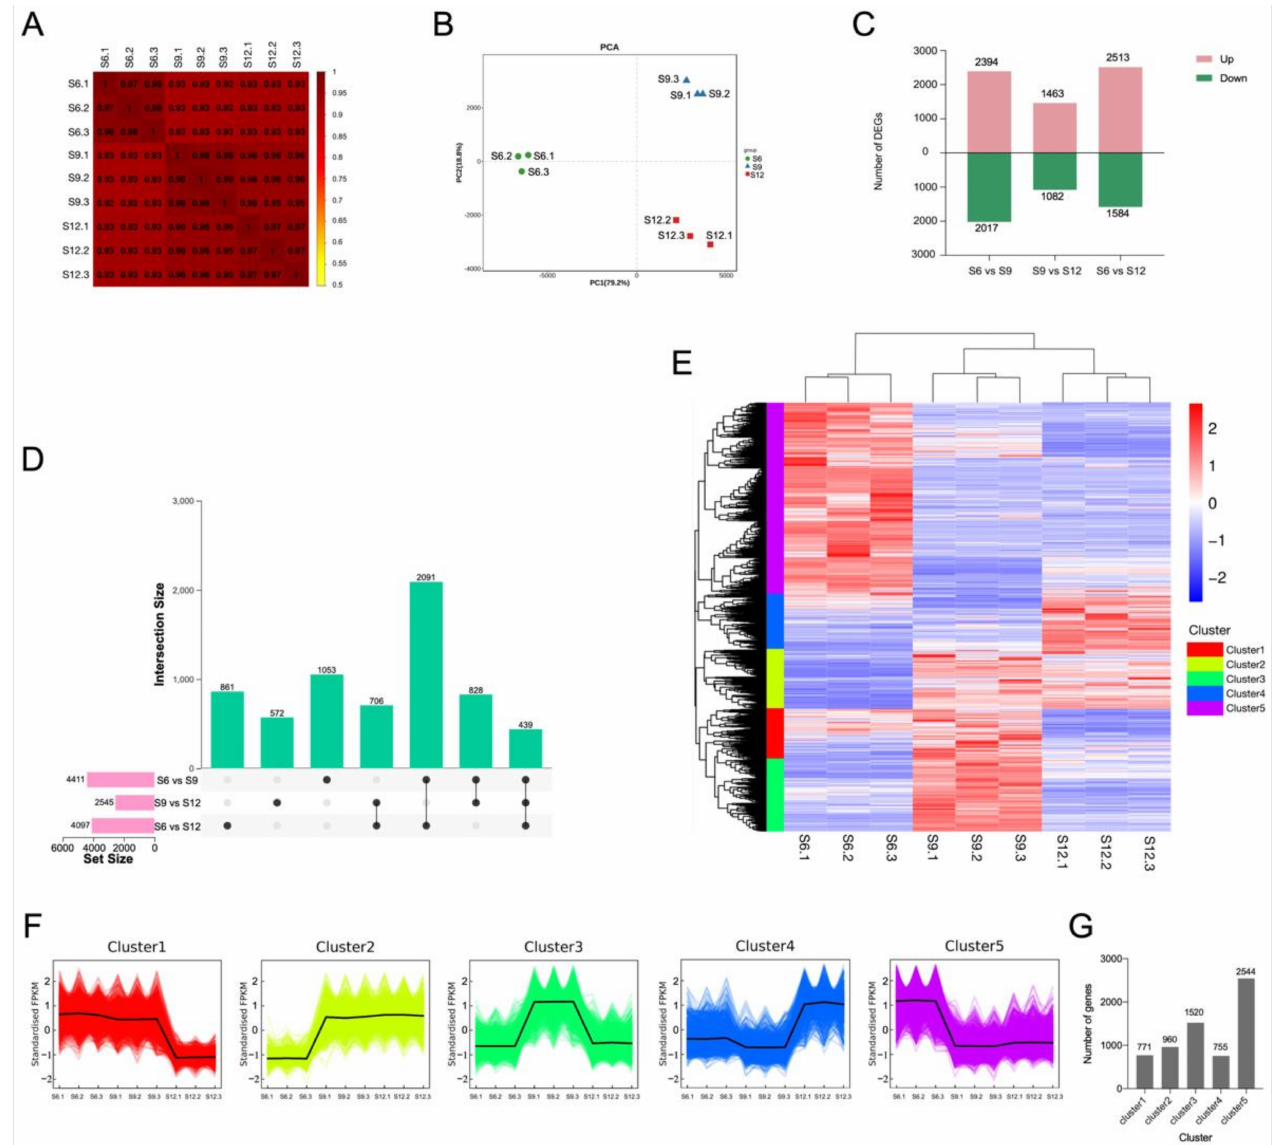
Figure 3. Transcriptome analysis of sweet cherries during development. ( A ) Spearman correlation coefficients of gene expression at different developmental stages; ( B ) PCA analysis of gene expression at each developmental stage; ( C ) the number of DEGs compared at any two different developmental stages; the number of upregulated and downregulated genes are represented by the bars above and below the x -axis, respectively; ( D ) upset plots of ubiquitously and exclusively expressed DEGs in pairwise comparisons across developmental stages; ( E ) hierarchical clustering of DEGs for all samples; ( F ) K-means clustering of DEGs expression trends, the expression profiles of genes in each cluster are represented in different colors, and the average expression profiles of all genes in each sample are represented in black; ( G ) summary of K-means clustering results, the specific number of DEGs contained in each